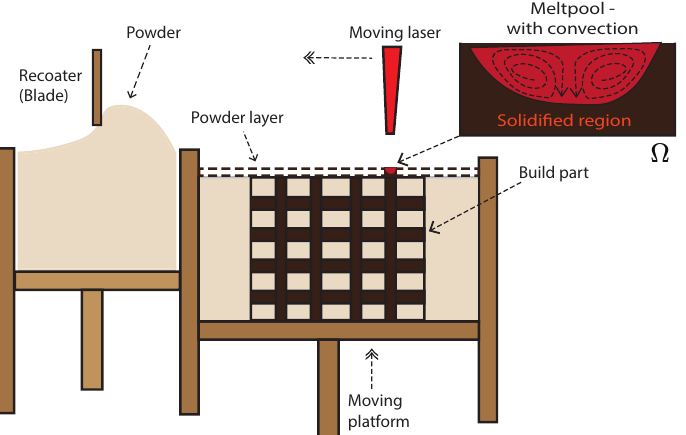
Figure 1. Schematic depicting the part-building process in Laser Powder Bed Fusion (LPBF). Laser irradiation on the powdered material causes localized melting and fusion of the metal powder on top of the partially built part. The localized melting results in a small pool of liquified metal referred to as the meltpool . Shown in the inset figure are the state of the powder under the laser—with the newly solidified region and a meltpool with convective flow of the liquified metal, and this region comprises the computational domain ( Ω ) of the numerical model presented in this